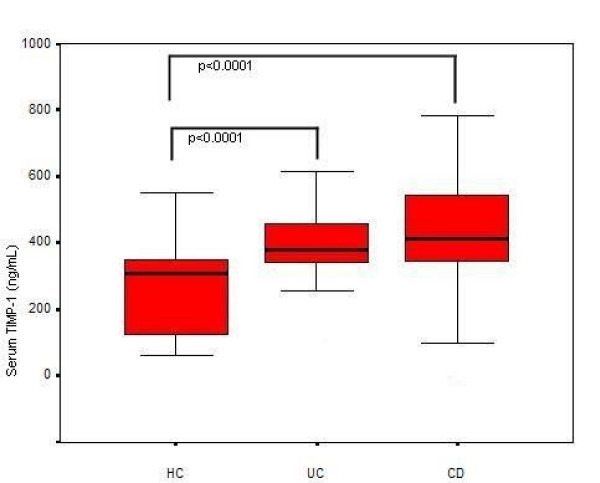
Bar graph showing TIMP-1 levels in UC, CD patients and HC and the statistical significance of mean differences.